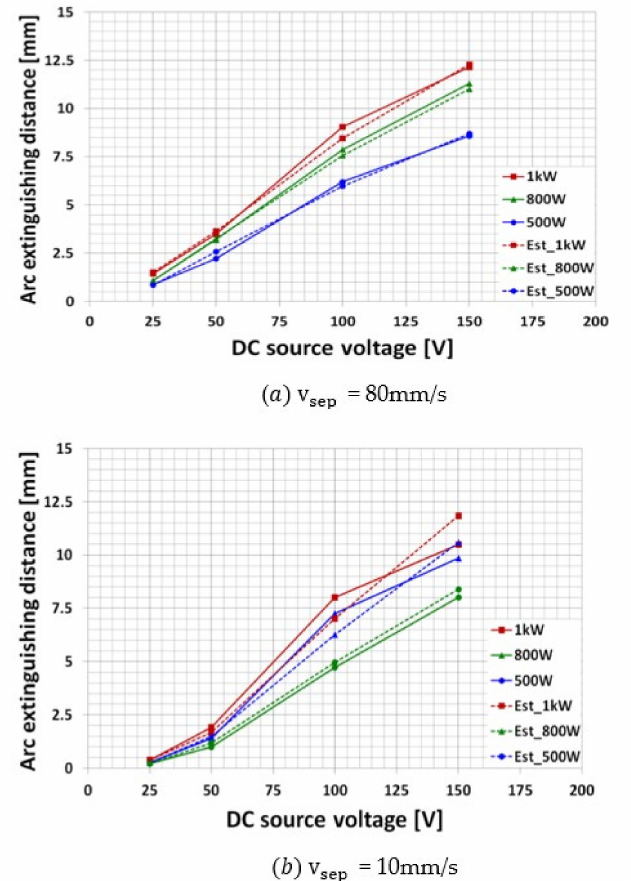
Figure 9. Arc extinction distance experimental value curve and estimated curve: Power supply voltage less than 200